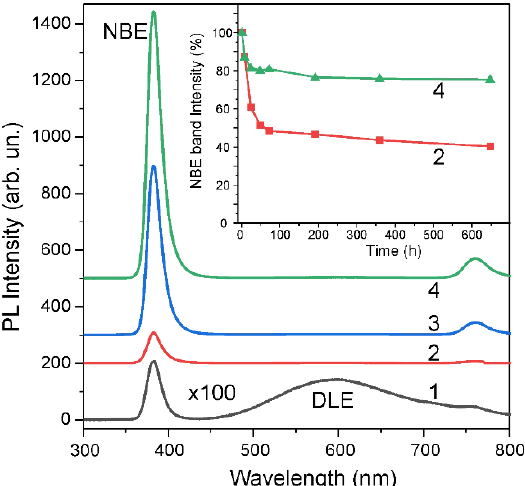
Figure 3. Room-temperature PL spectra of the as-grown ZnO (1), P-sample (2) and A + P samples preliminary annealed at 250 ◦ C (3) or 400 ◦ C (4) in air followed by H-treatment. Inset: dependence of the normalized NBE intensity for P-sample (2) and A + P sample (4) versus aging